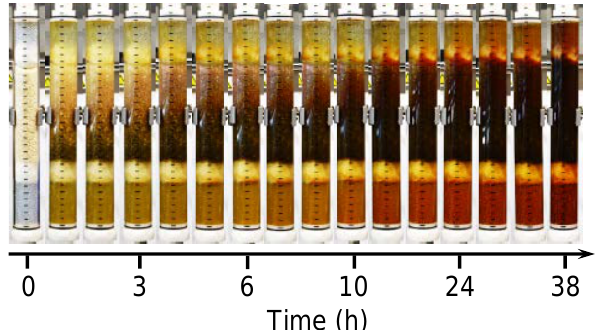
Figure 5. Images of the increasing color change and intensity of the packed bed column as a function of time from left to right; column was filled with chitosan and fixed with glass balls and glass wool at the ends of the column.